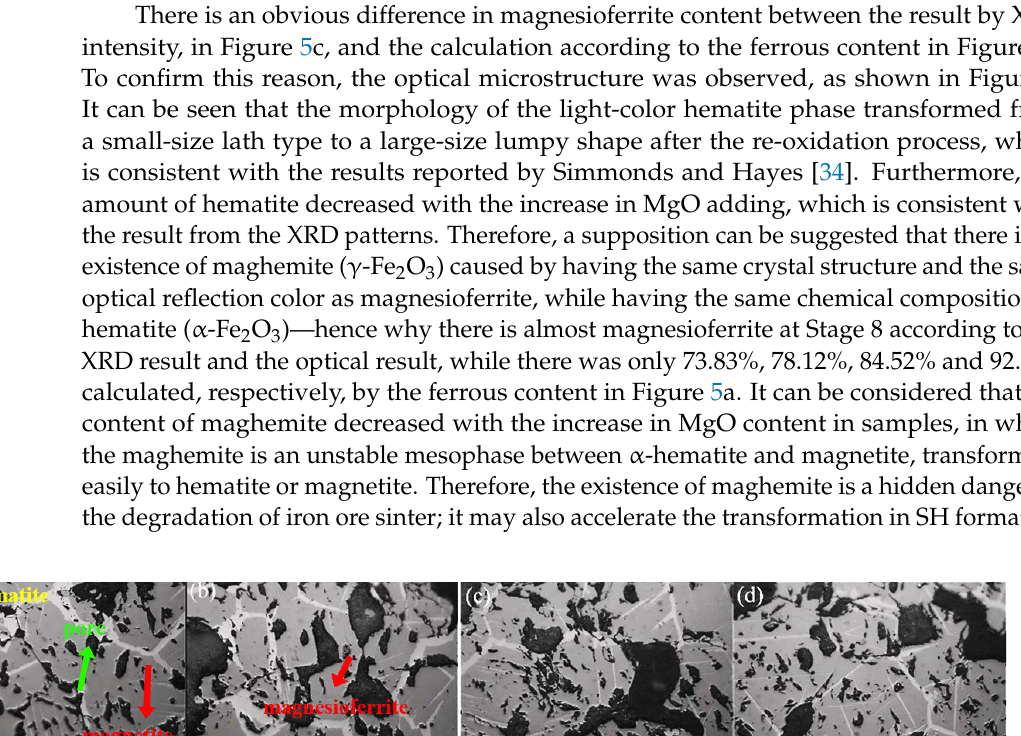
Figure 6. Optical microstructure of samples with different content of MgO ( a ) MgO-free; ( b ) 1.0% MgO; ( c ) 3.0% MgO; ( d ) 5.0% MgO. Reflection colors: Grey—hematite; Dark grey—magnesioferrite; Black—pores.